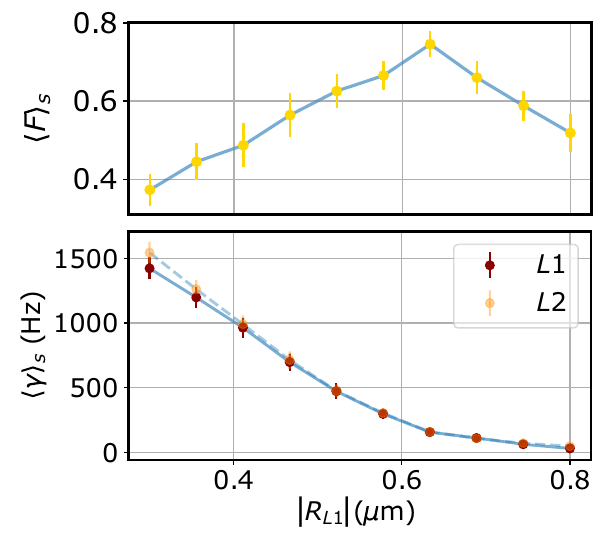
FIG. 8. The influence of corrector positioning. Top: steady- state overlap. Bottom: mean correction rates. The averages are considered from 10 ms onward, when the device is well settled in the steady state. The error bars correspond to one standard devi- ation. Each point is evaluated from 10 2 quantum trajectories. All remaining parameters are the same as in Fig.